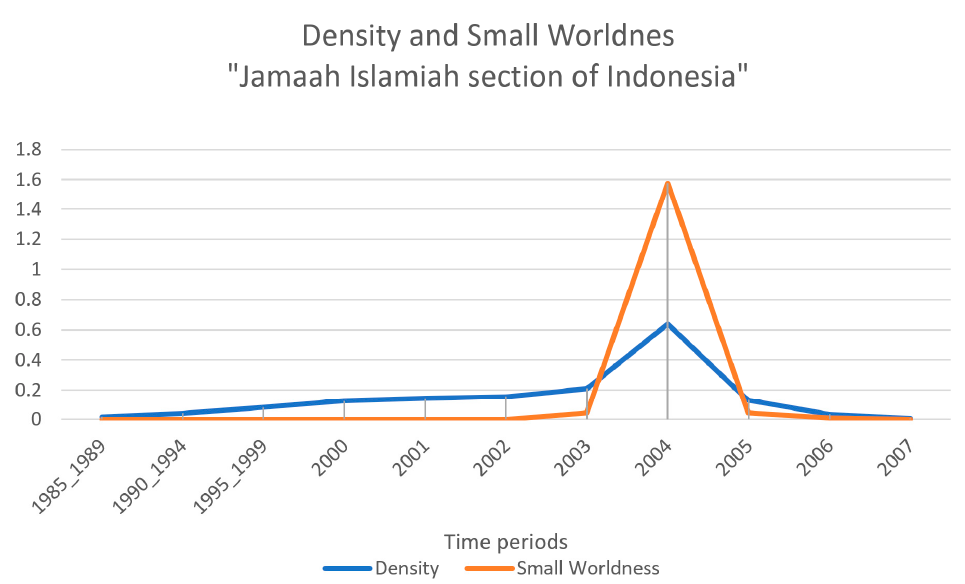
Figure 5. Temporal development of density and small worldness for the “Jamaah Islamiah section of Indonesia”. Both density and small worldness increase rapidly starting in 2003, reaching a maximum in 2004 and decreasing rapidly, falling to zero in 2005. The observed temporal development is more pronounced for small worldness, by an order of magnitude. More specifically, the small worldness increase is about by 3000%, while the density increase is about 200%.